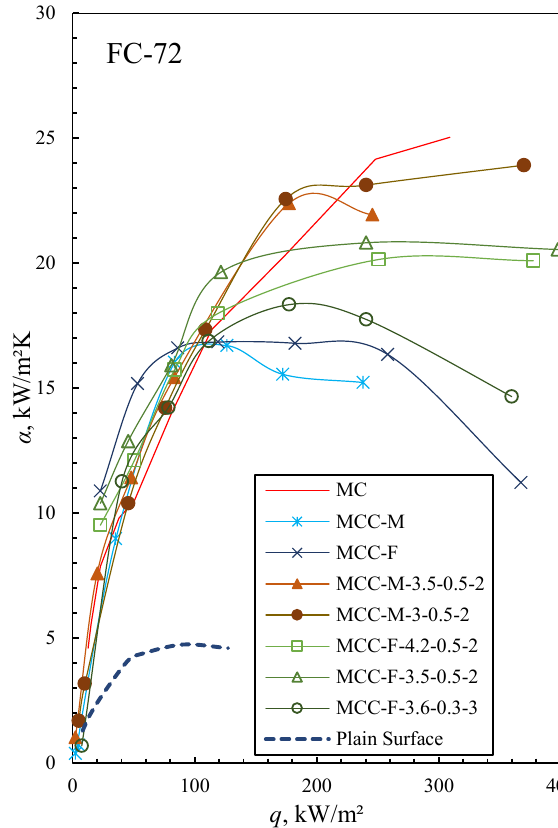
Fig. 7. Boiling curves for FC-72, heat transfer coefficient